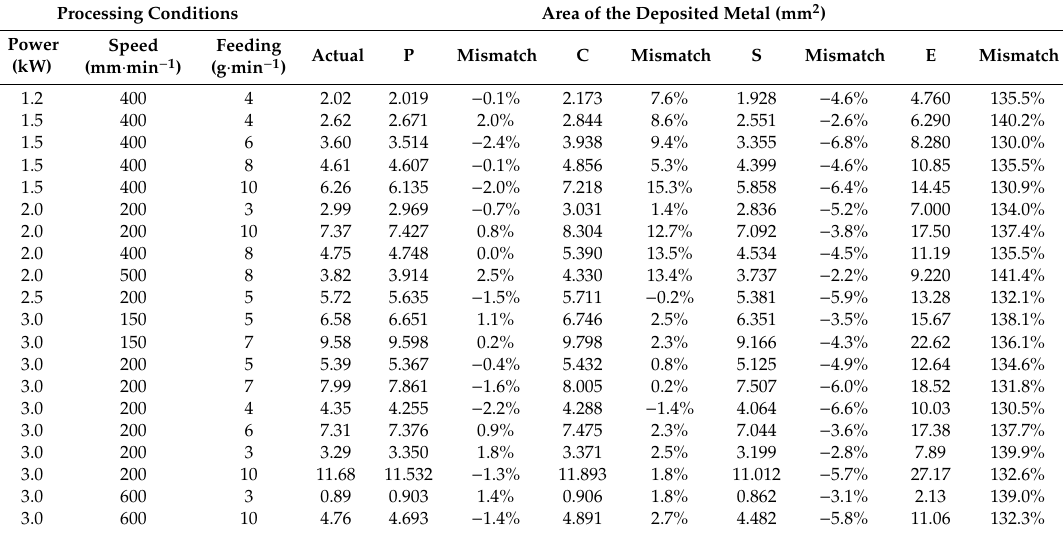
Table 5. Comparison among actual and subtended area of the deposited metal in single-track deposition for different shape: parabolic (P), circular (C), sinusoidal (S) and semi-ellipses (E). Processing